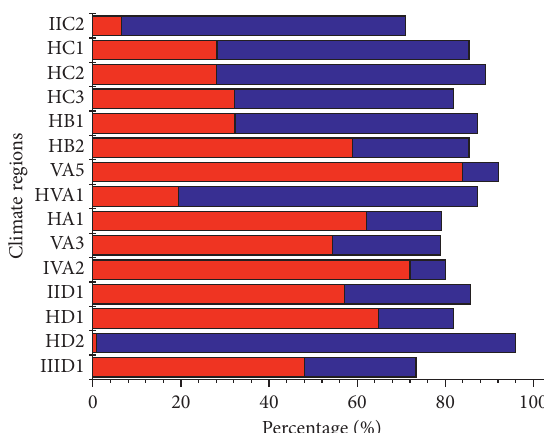
Figure 8: Percentages of areas tending to be drier (red bar) and wetter (blue bar) significantly ( p < 0 . 1 ) in different climate regions based on the trend of SPEI-12 in the QTP during